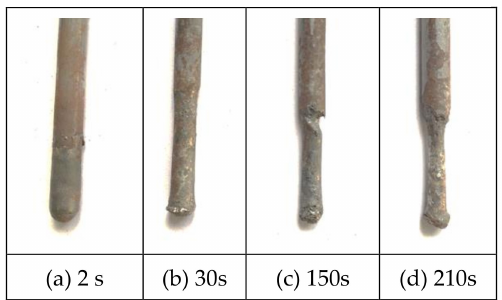
Figure 3. Appearance of the steel bar after immersion in the hot metal: ( a ) 2 s, ( b ) 30 s, ( c ) 150 s, ( d ): 210 s.